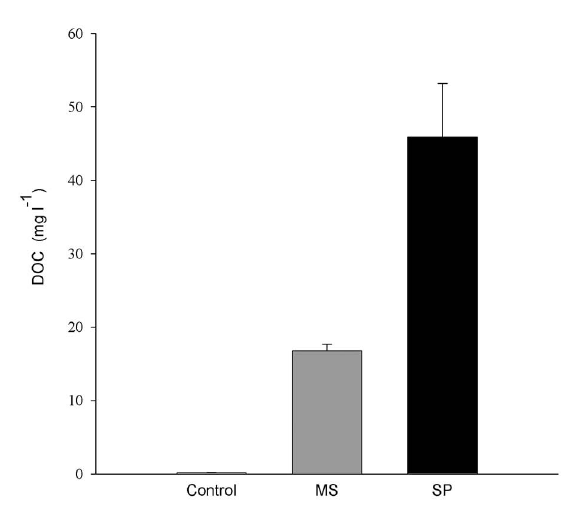
F ig . 5. – Dissolved organic carbon concentration (means±se, n=3) in the Stylophora pistillata (SP), Montipora stellata (MS) and con- trol tanks. All three categories were significantly different from each other